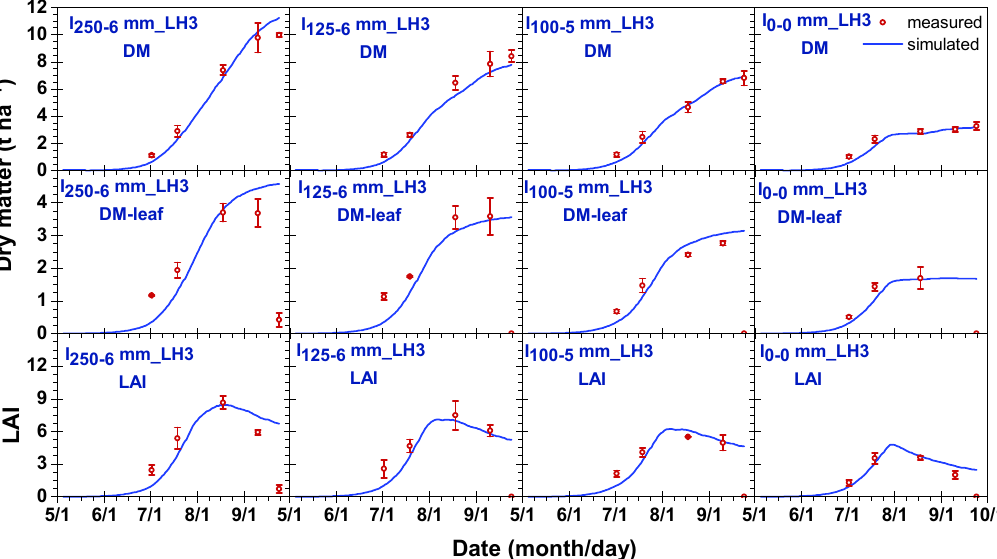
Figure 3. Comparison of measured and simulated values of LAI, DM (the dry matter weight of root, stem and grain) and DM-leaf (the dry matter weight of leaf) under different irrigation schedules of LH3 in 2020. Table 2. Statistical criteria for simulation of soil water storage LH1 and LH3 in 2020.